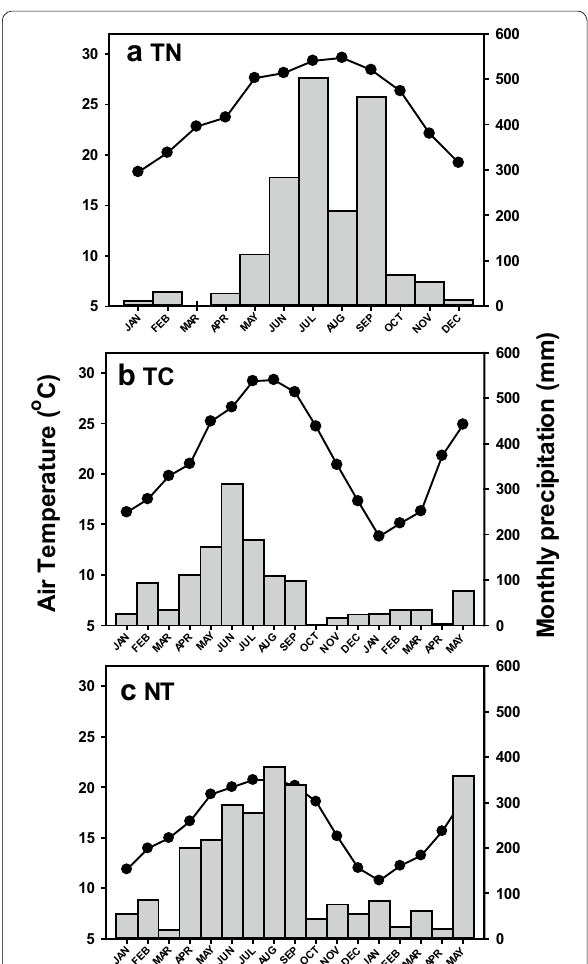
Fig. 1 Monthly mean air temperature (°C, black circle) and precipita‑ tion (mm, gray bar) from January 2010 to December 2010 at TN plan‑ tation and from January 2010 to May 2011 at TC and NT